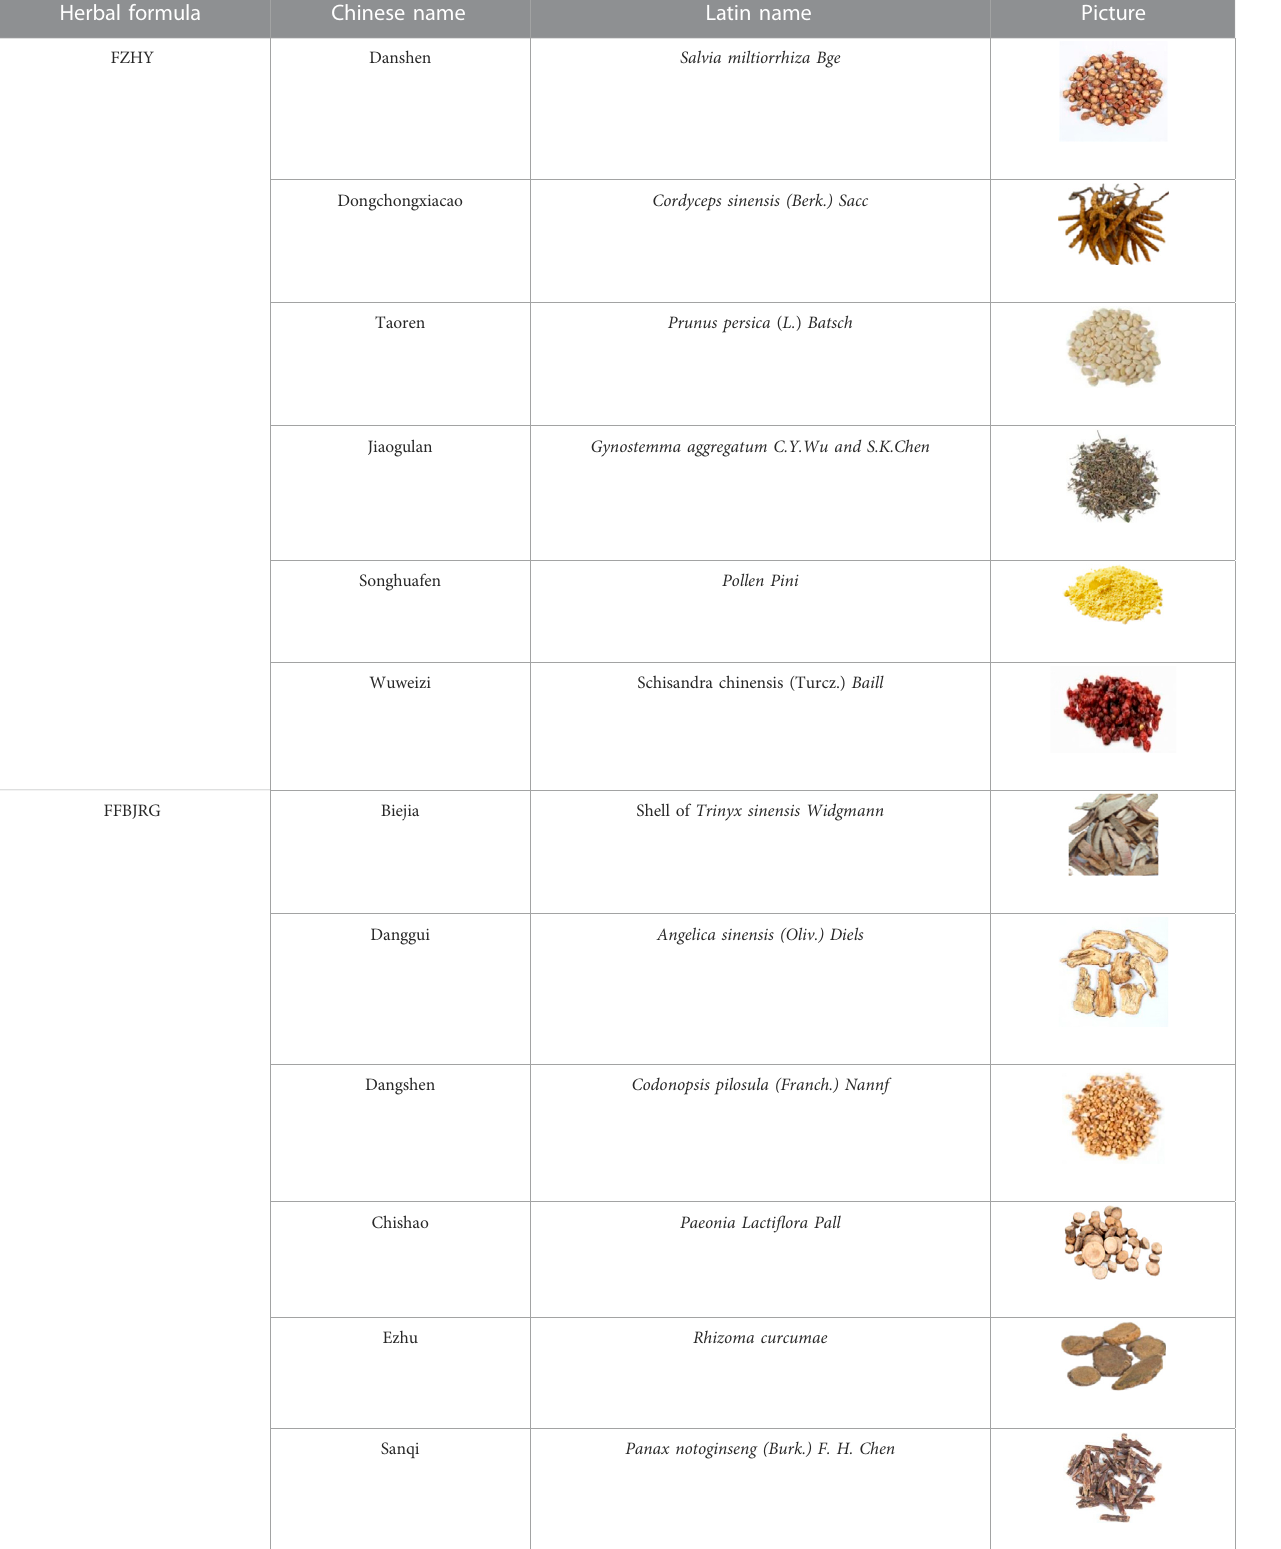
TABLE 3 The herbal formula of FZHY, FFBJRRG and ALHX. Herbal